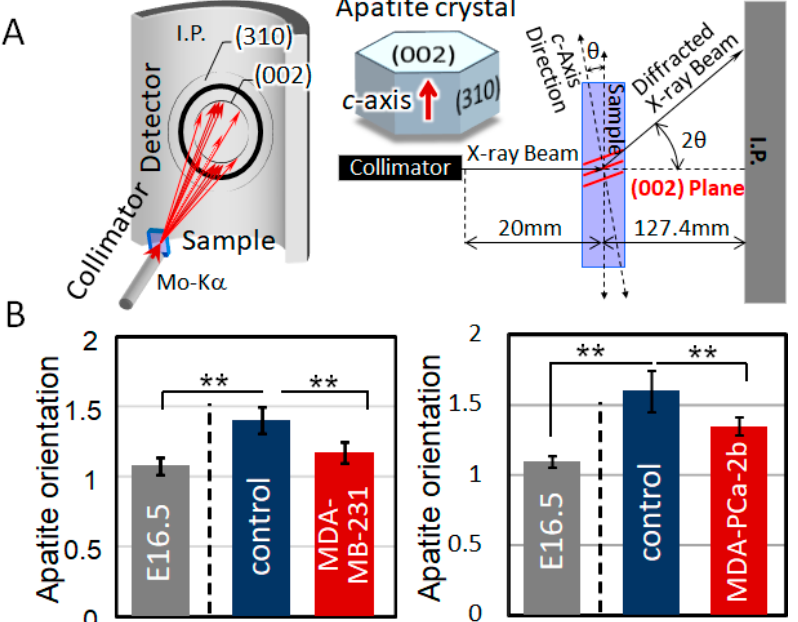
Figure 2. ( A ) Schematic illustration of the analysis of apatite orientation using transmission microbeam XRD (X-ray diffraction) method. Preferential orientation of the c -axis of apatite crystals was analyzed with the integrated intensity ratio of (002)/(310). ( B ) Quantitative analysis of apatite orientation along the longitudinal direction of the bone before cultivation (E16.5) and after cultivation (separated by dot lines) with or without tumor cells. ** p < 0.01.